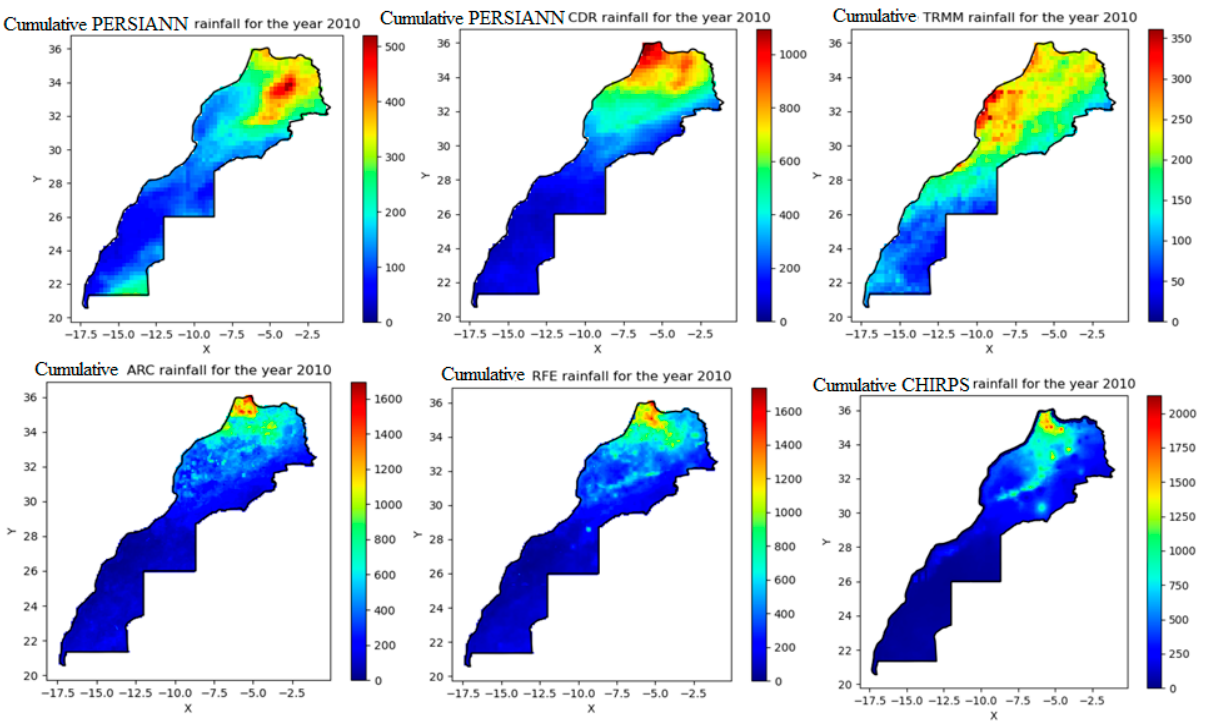
Figure 2. Simulated satellite-based cumulative rainfall for the year 2010.